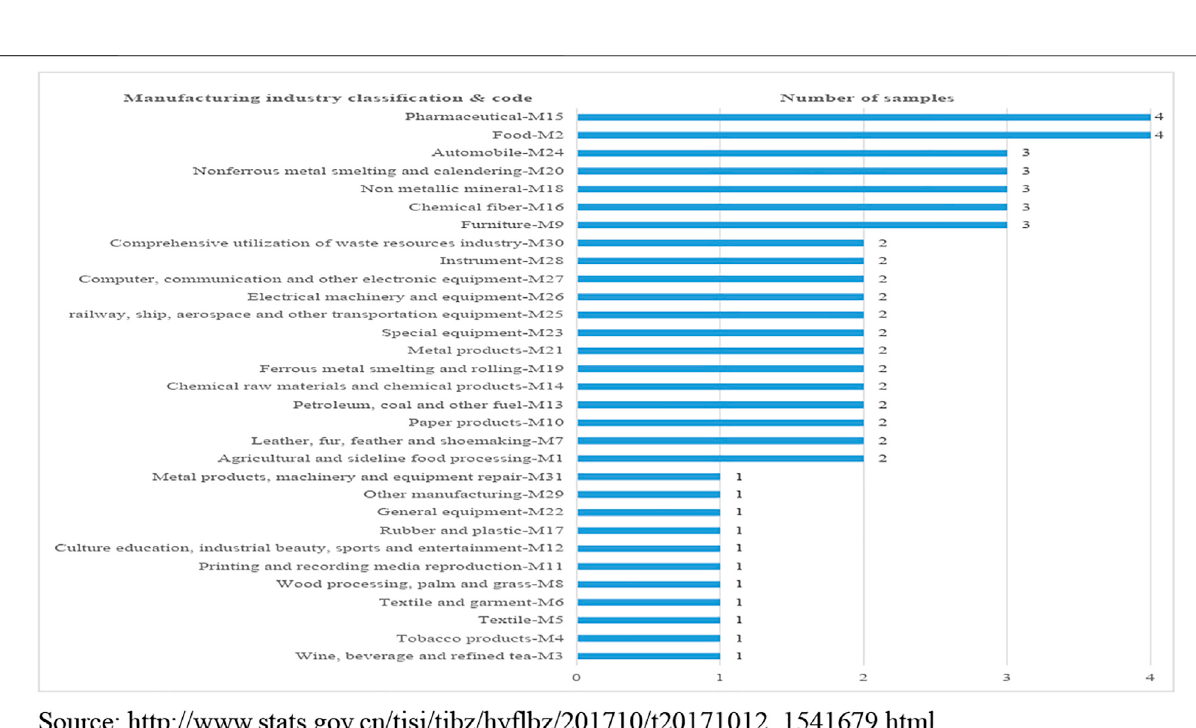
Frontiers in Environmental Science |